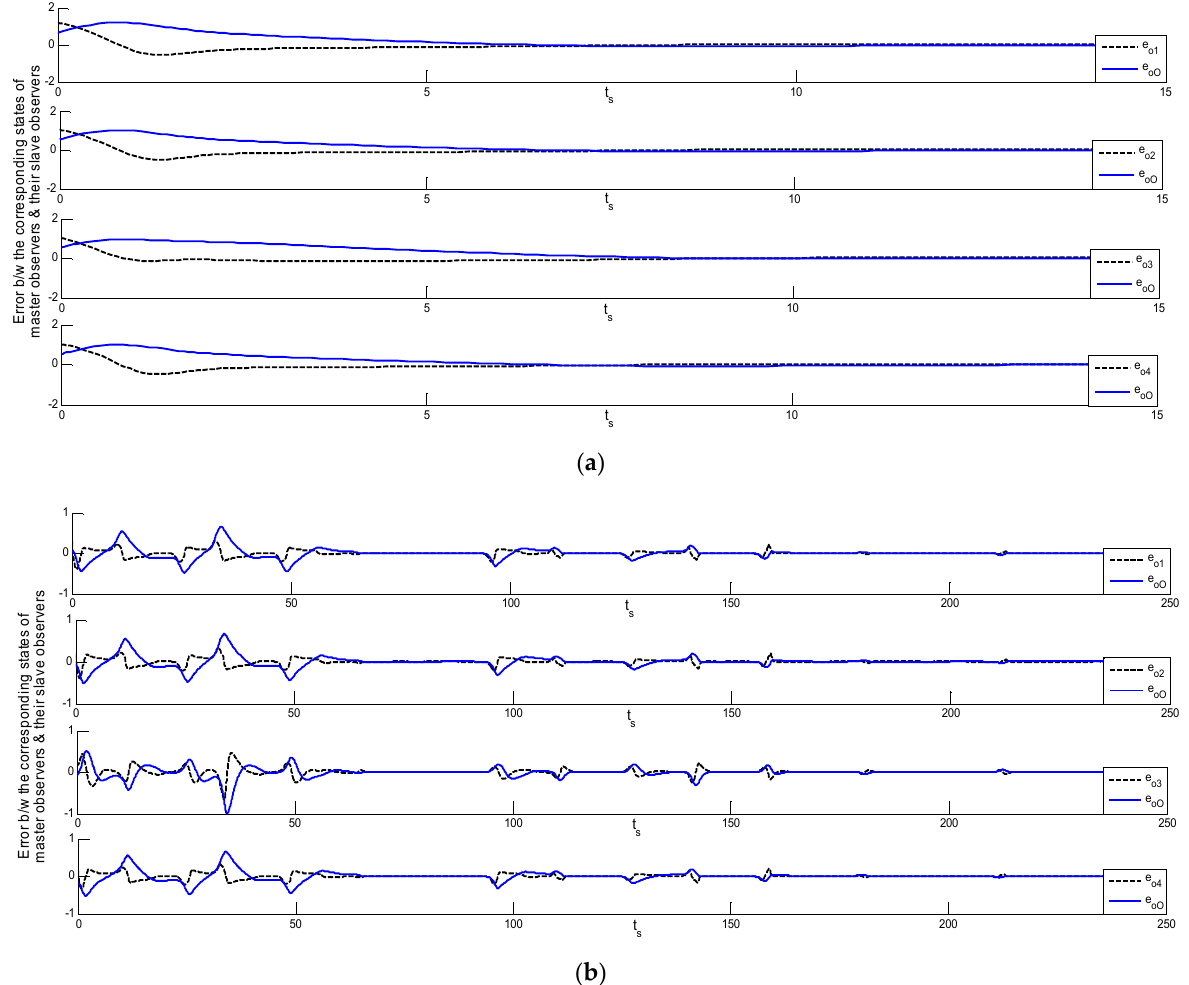
MO -X SIO ) of Theorems 1 and 2.